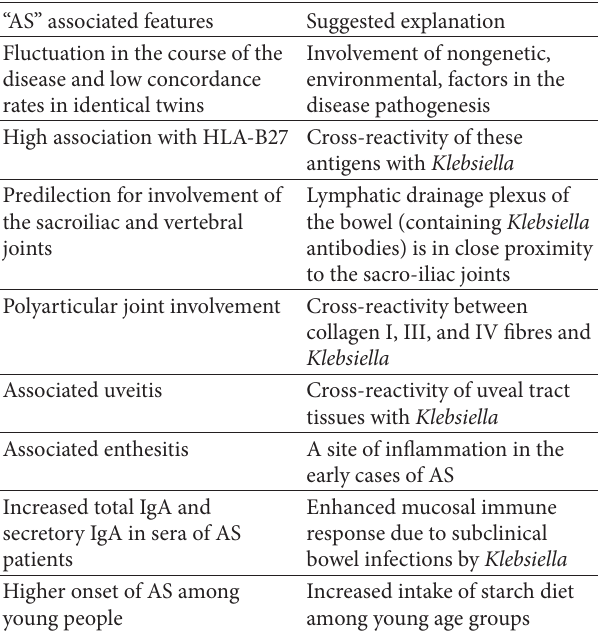
Table 1: Possible explanations for some of the predominantly associated features in